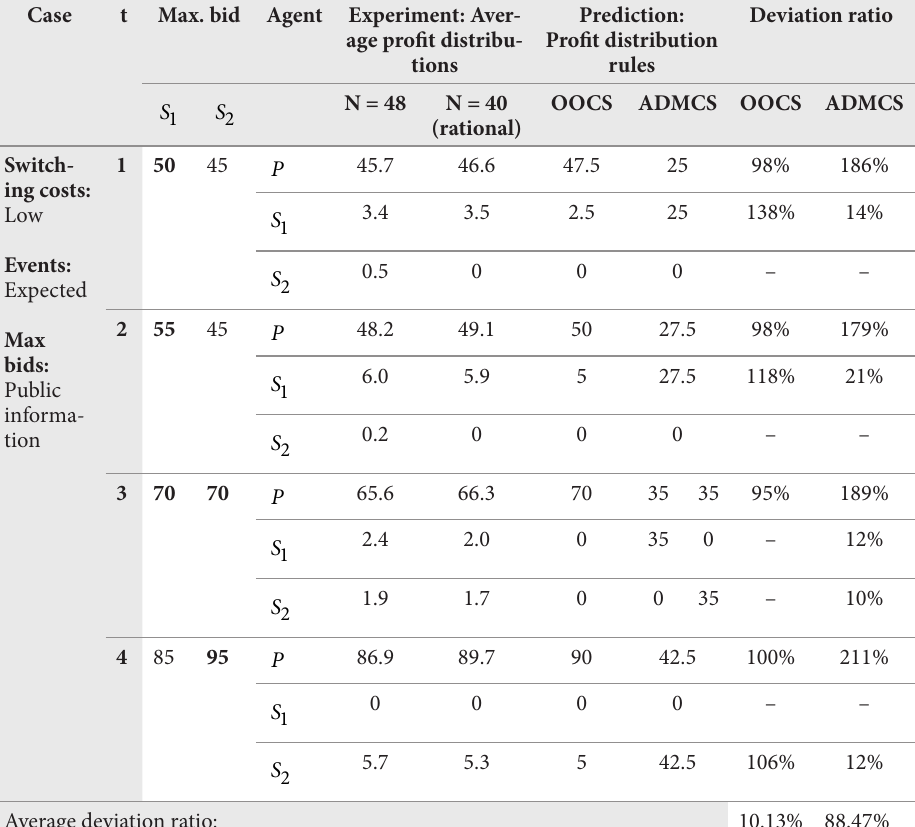
Table 1. Maximal bids and the comparison of the OOCS-rule and the ADMCS-rule with the empirical results for low agent switching costs and maximal suppliers’ bids that are public information Case t Max. bid Agent